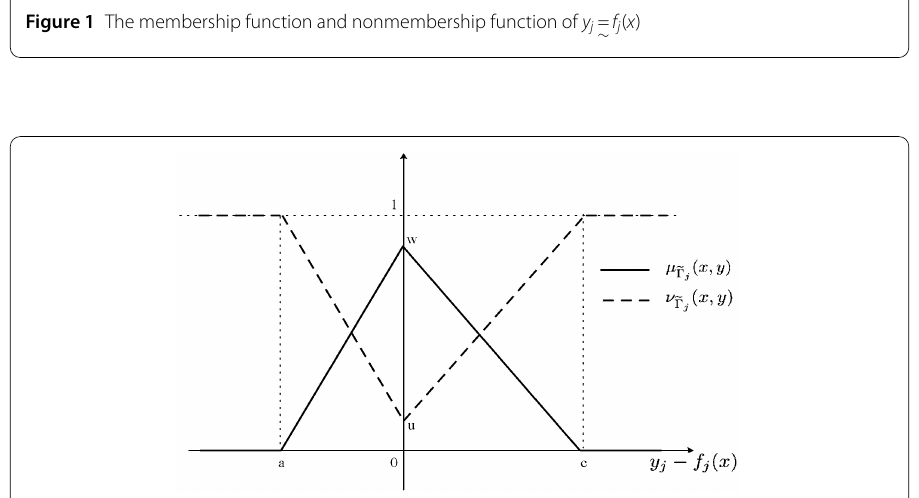
Figure 1 The membership function and nonmembership function of y j =